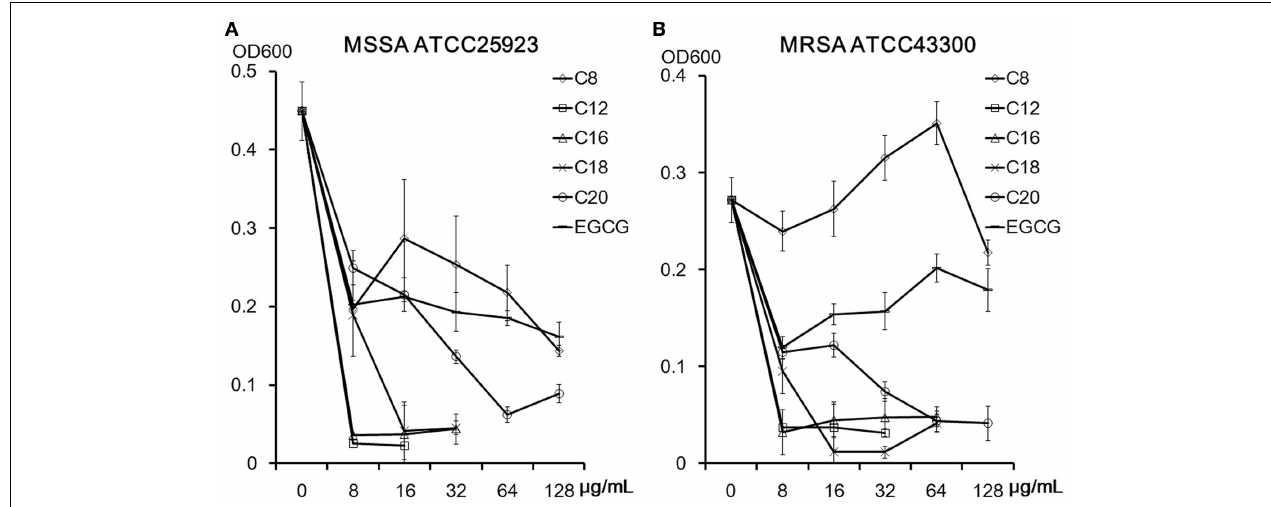
FIGURE 2 |Acyl chain length of EGCG derivatives and their antistaphylococcal activities against MSSAATCC25923 (A) and MRSAATCC43300 (B). Mean ∓ SD of each four wells optical density (600nm) after 18h incubation are shown.